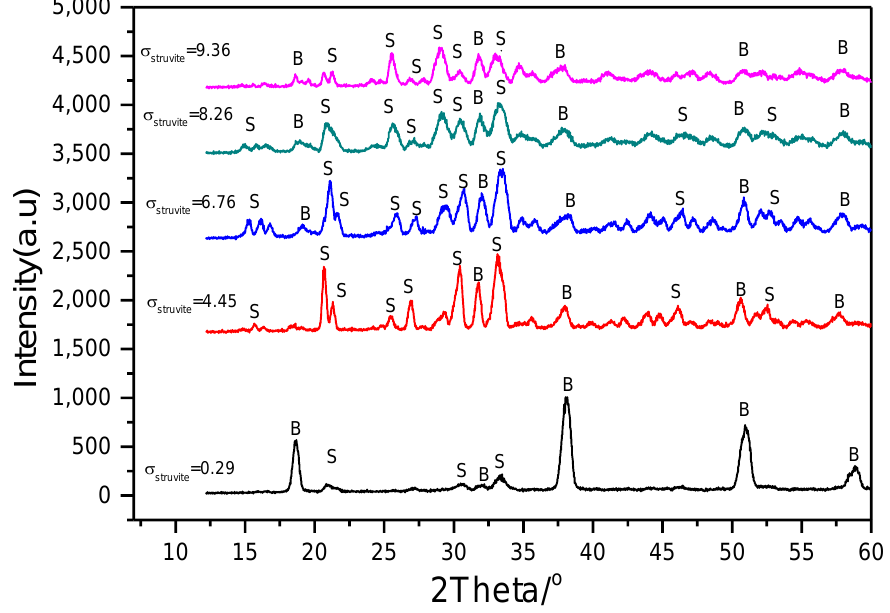
Figure 12. Precipitation of struvite from supersaturated solutions: ( ◼ ) Method A; ( ◼ ) Method B; ( ◼ ) synthetic wastewater; 25 °C. The precipitate in SWW supersaturated with respect to struvite was identified as struvite (Figure 13). Brucite was also detected in the supersaturated SWW with rela- tive supersaturations in the range between, σ struvite = 0.29–9.36, however, the reflections are weak.